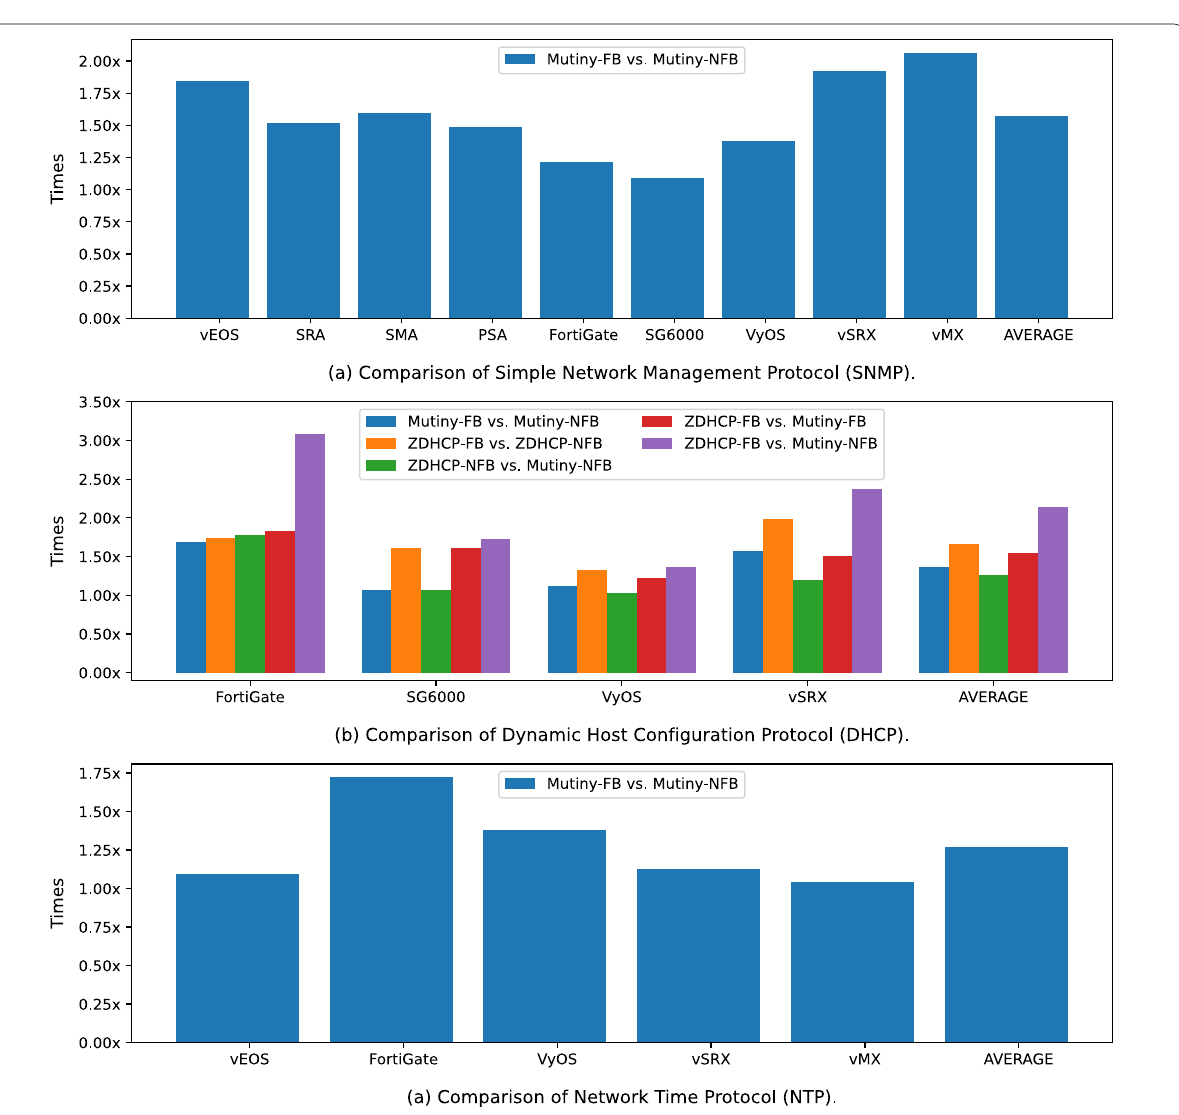
Fig. 6 Edge improvement of SNMP and DHCP